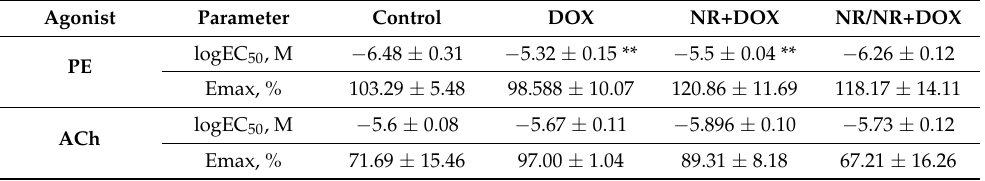
Figure 7. Mesenteric artery functional activity. ( A )—dose-dependent response curves to phenyle- phrine (PE); ( B )—dose − dependent response curves to acetylcholine (ACh); ( C )—area under the curves (AUC) for PE-dependent response; and ( D )—AUC for ACh-dependent response. *— p < 0.05, and ***— p < 0.001, significant difference compared to control group. Values represent mean ± SEM mean from 9 arteries of 3 rats in every group (n = 36). Control represents control group; DOX repre- sents doxorubicin group; NR+DOX represents nicotinamide riboside + doxorubicin group— combined mode ; and NR/NR+DOX represents nicotinamide riboside/nicotinamide riboside + doxorubicin group— preventive mode . Table 3. Dose-dependent curve parameters.